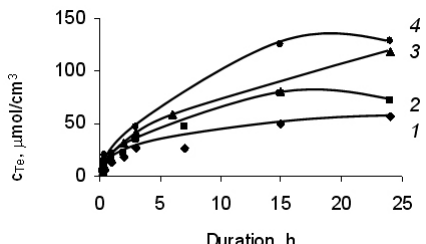
Figure 13. Adsorbtion isotherms of tellurium on PA surface at 20 o C as a function of exposure time in a solution of